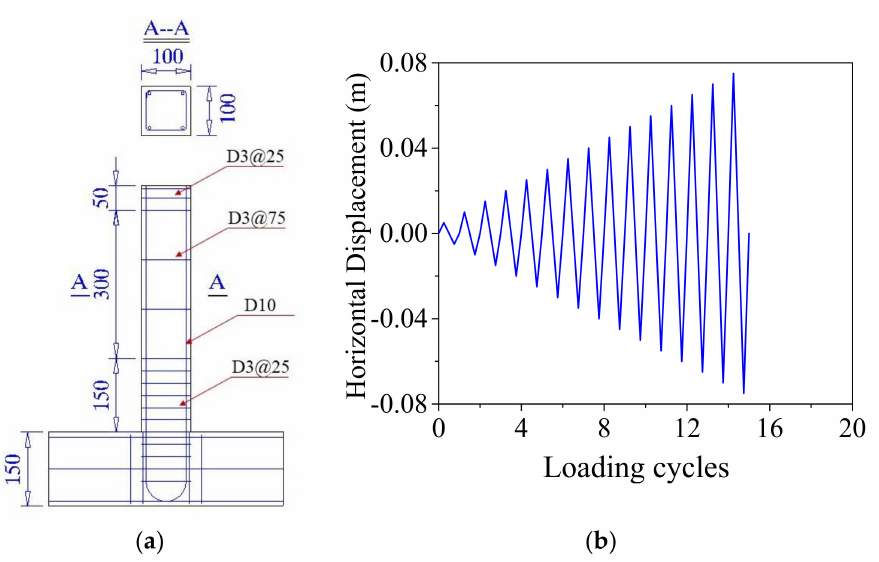
Figure 5. Specimen and loading protocol. ( a ) ECC-reinforced column specimen (Unit: mm); ( b ) Loading protocol for quasi-static